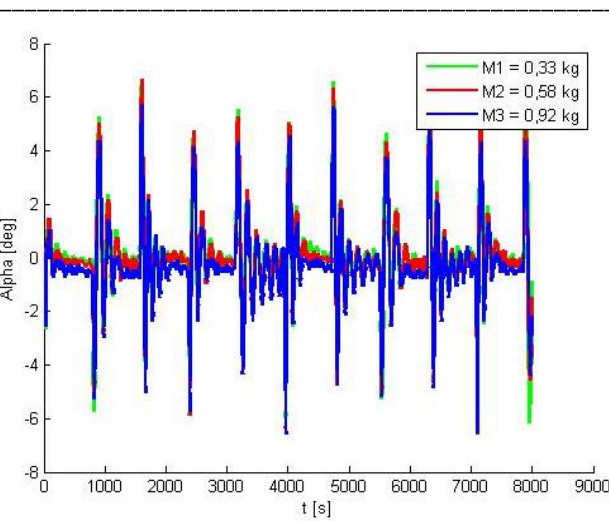
Fig. 16. Anti-swing 5DOF fuzzy logic regulator α angle of the payload oscillation simulation